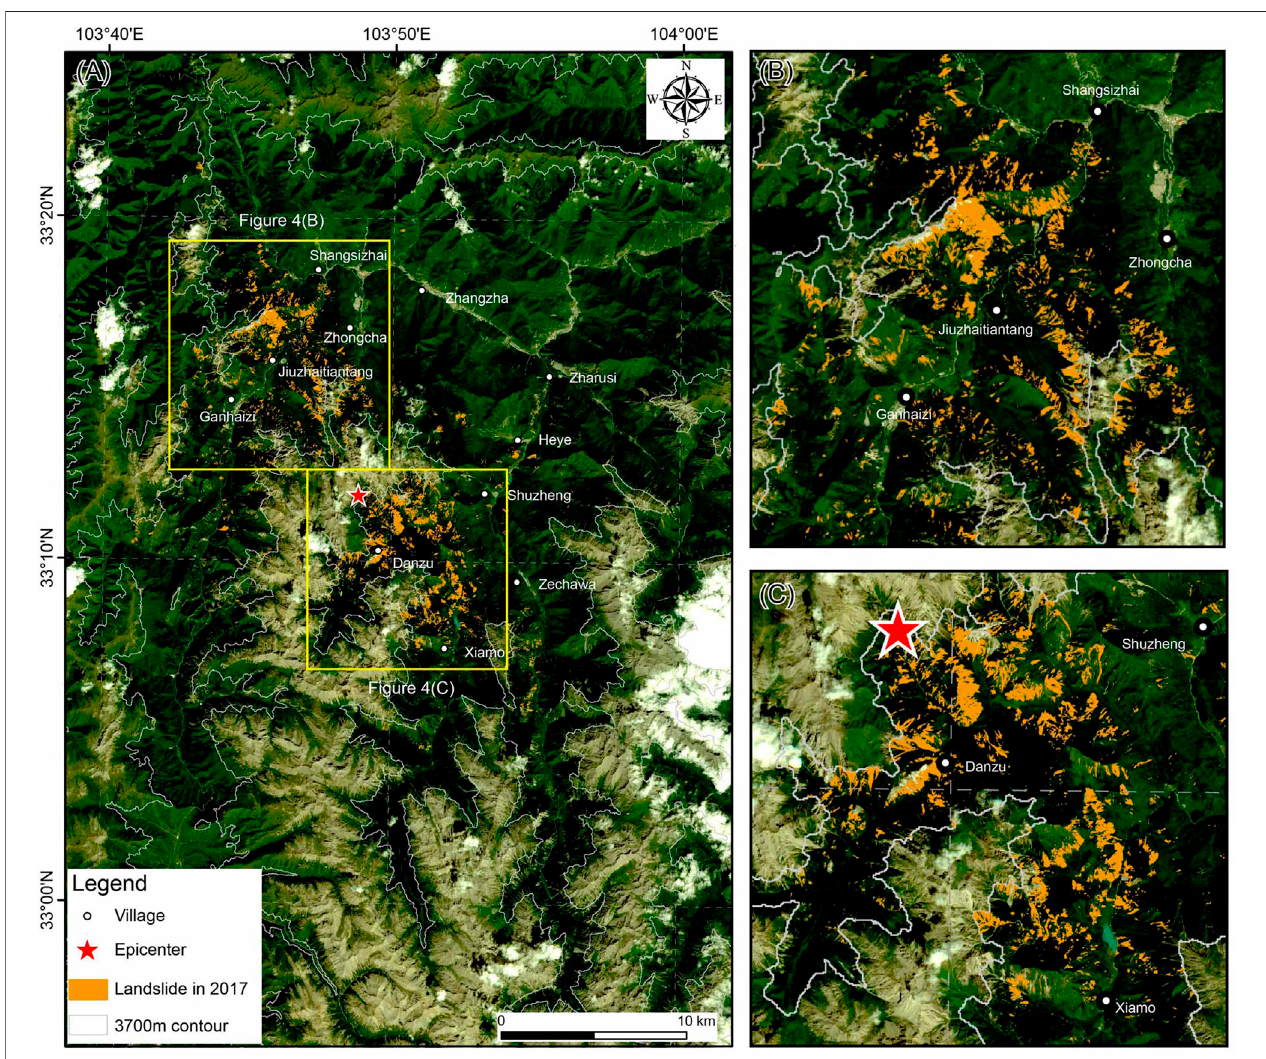
FIGURE 4 | Inventory map of the landslide in 2017 (A) Landslide map (B) Landslide map of Jiuzhaitiantang (C) Landslide map of Panda Lake.